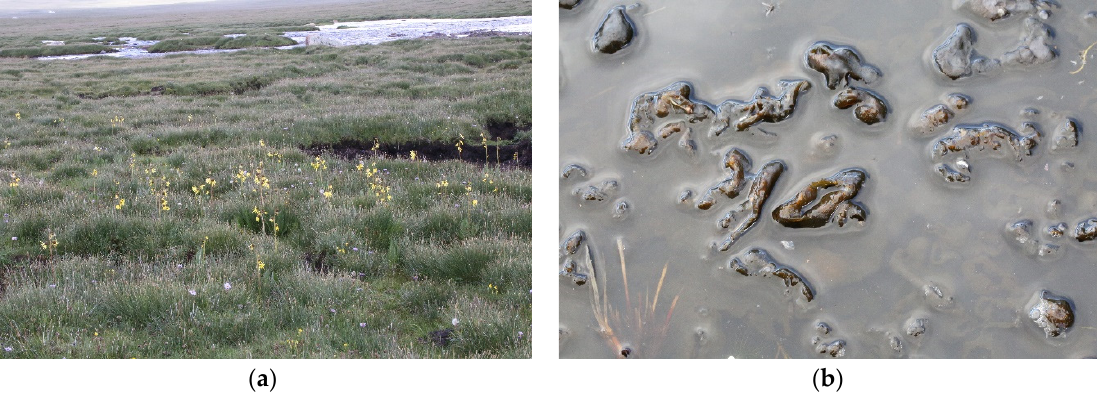
Figure 1. ( a ) General appearance of the sampling site; ( b ) mass of visible macroscopic colonies in fresh water. Photos were taken by X. Wen.